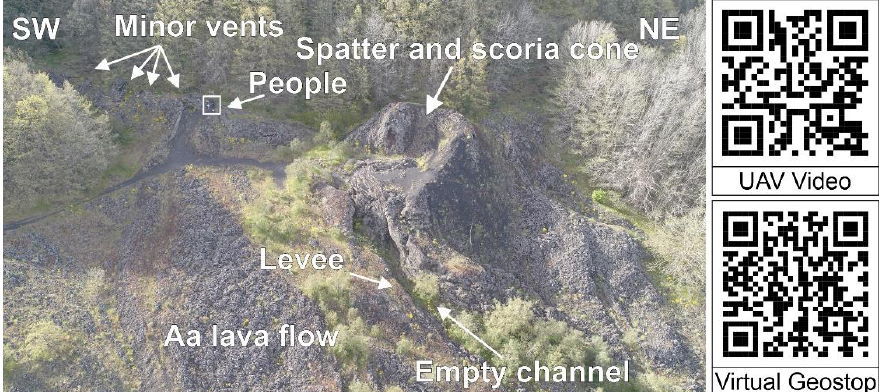
Figure 9. The image on the left shows geostop 7 through a NW-looking UAV-captured picture, people for scale. The QR codes on the right enable opening the corresponding UAV-captured video and the related VG. By using a mobile phone or a tablet, open up the QR code reader. Hold your device over a QR code, so that it is clearly visible on your screen. Press the notification and wait a few seconds.